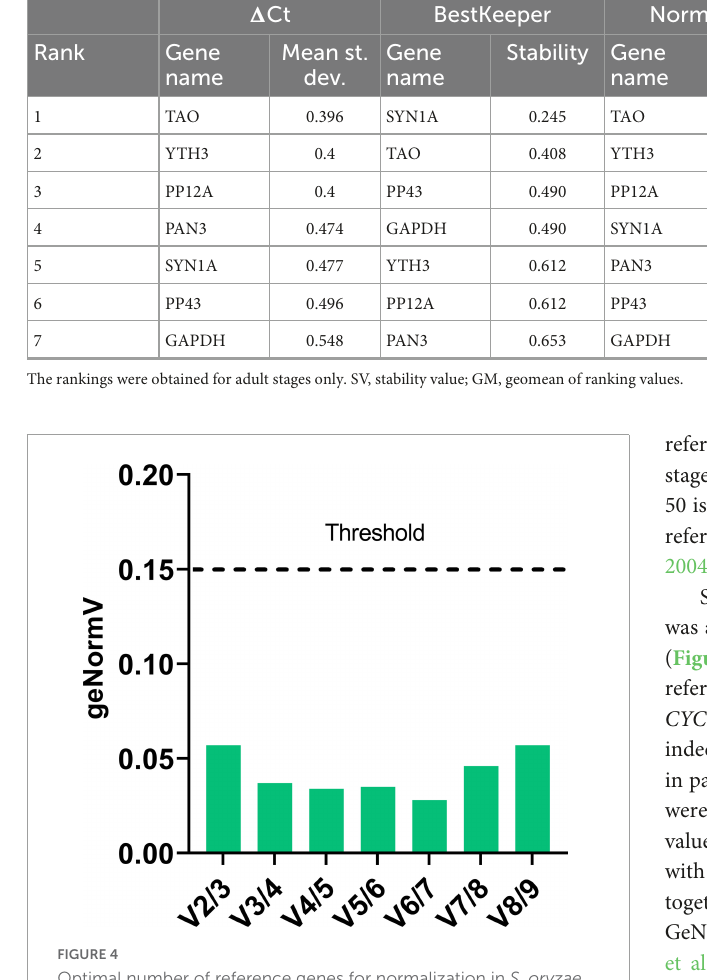
TABLE 4 Ranking of candidate reference genes for various Sitophilus oryzae developmental stages, according to the (cid:49) Ct method, BestKeeper, NormFinder, GeNorm, and Reffinder.